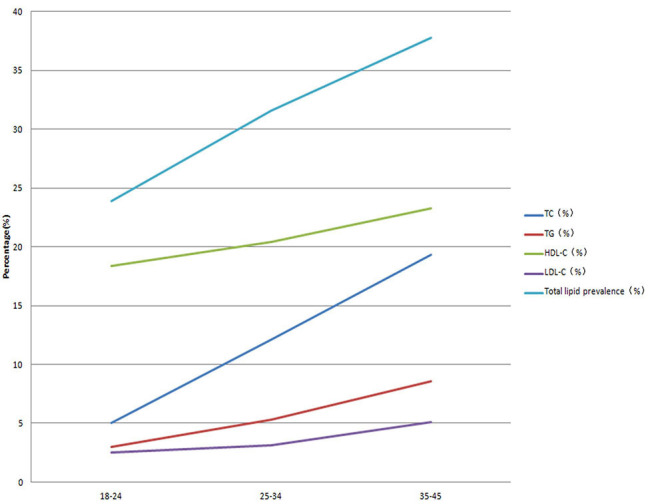
Prevalence of dyslipidemia by different ages.